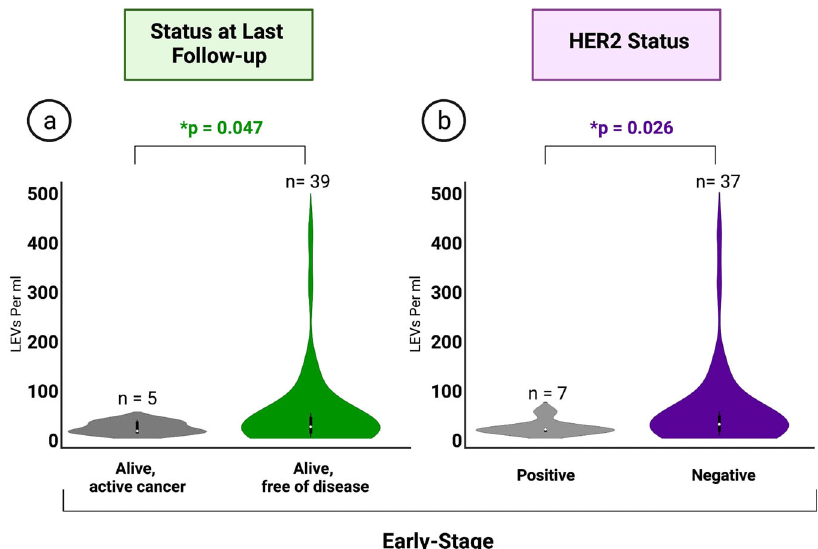
Fig. 4 Clinical Data. a Comparison of summed LEV levels between differing statuses at last follow-up in early-stage BC. Kruskal-Wallis H test (one-way ANOVA) performed. All p values below *0.05 considered statistically signi fi cant. b Comparison of summed LEV levels between early- stage patients with clinically identi fi ed HER2 + and HER2- tumors. Kruskal-Wallis H test (one-way ANOVA) performed. All p values below *0.05 considered statistically signi fi cant. Data illustrated in truncated violin